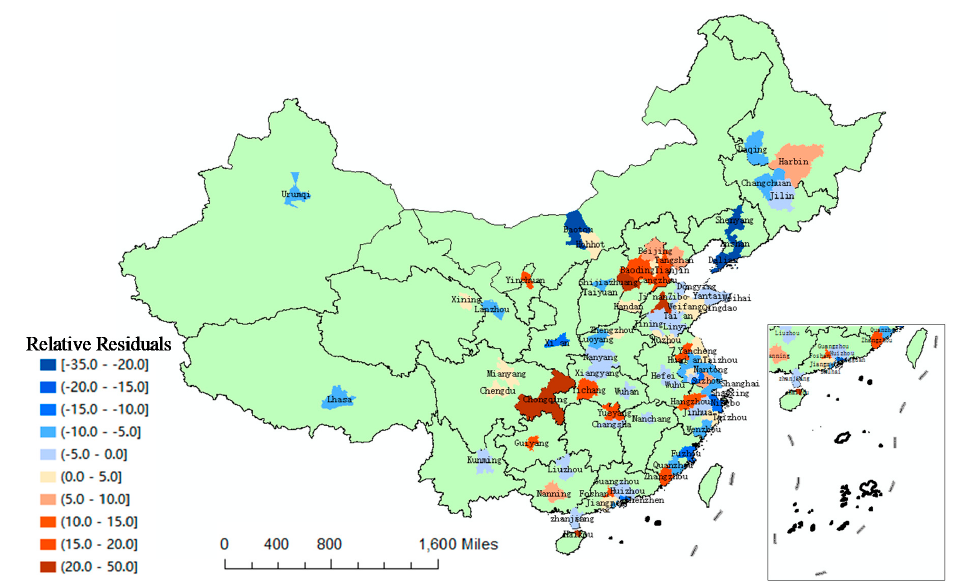
Figure 10. Distribution of the relative residuals of 85 Chinese cities by using OSM road network density.